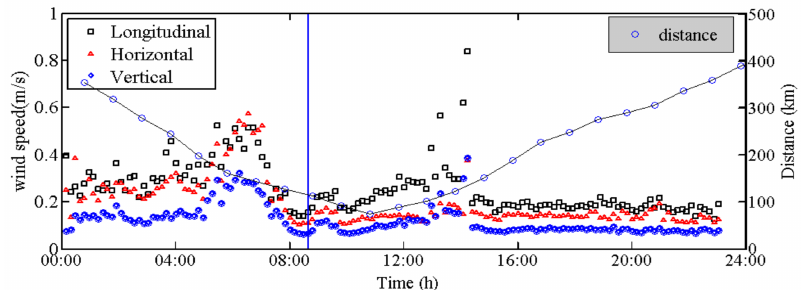
Figure 12. Measured turbulence intensity.